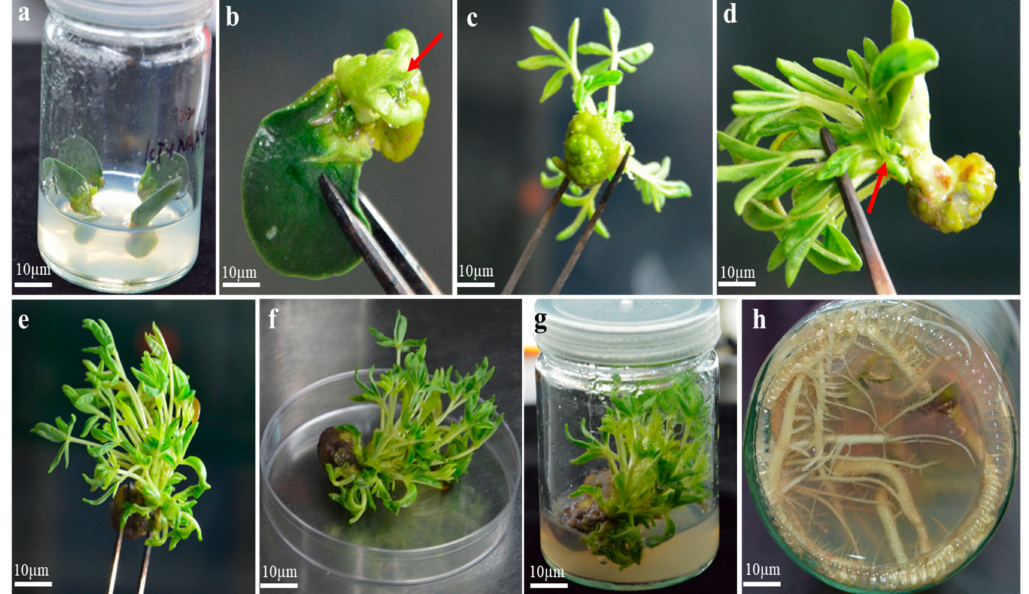
Figure 4. Whole regeneration of Lupinus albus on 1 M519 medium using HCN explants. ( a ) HCN 2 inoculated on 1 M519 media ( b ) after 7 days cotyledon develop new bud ( c ) after 14 days small plantlet 2 appears ( d ) after 21 days more shoots generate ( e ) after 28 days shoot length increase (f) after 28 days plant bud turns into dark brown color ( g ) plant inoculated on medium containing (KT 4.0 mg L − 1 + NAA 0.1 mg L − 1 ) ( h ) individual shoot cultured on 1 M519 medium with (IAA 1.0 mg L − 1 + KT 2 0.1 mg L − 1